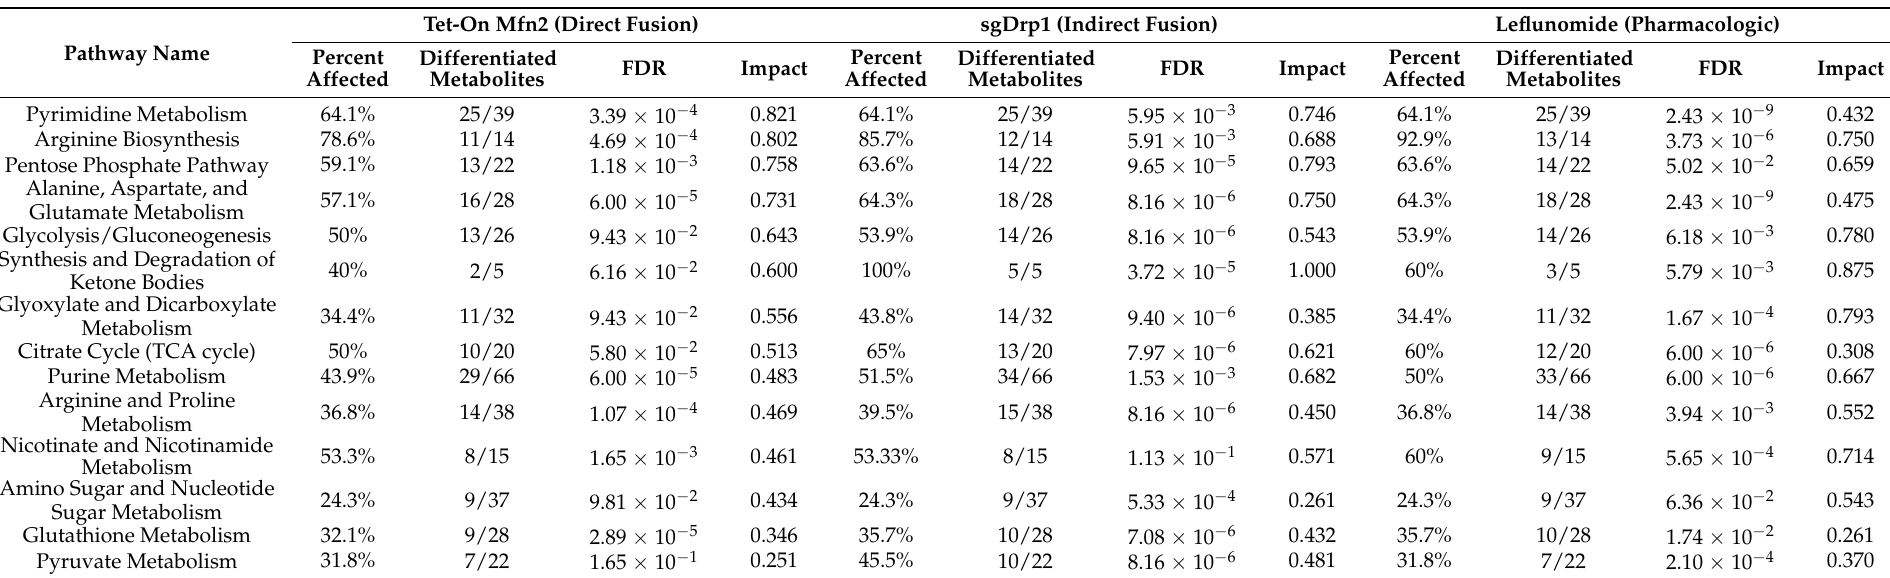
Table 1. Common altered metabolic pathways from the initial metabolite set across pathways supporting mitochondrial fusion. Pathway analysis included only pathways with an FDR < 0.05, impact > 0.25, and more than 20% of the metabolites in the pathway